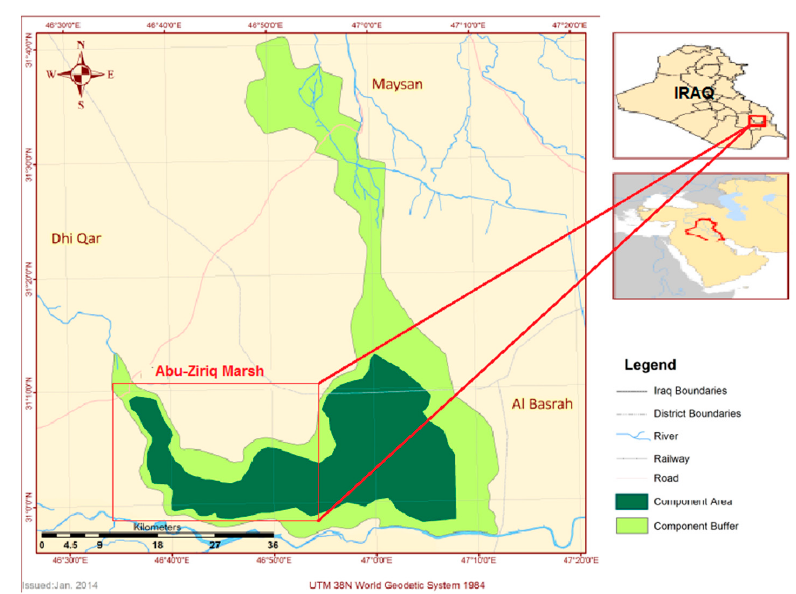
Figure 4. General location of Abu-Ziriq marsh. Table 1. Monthly records of water quality parameters per year.